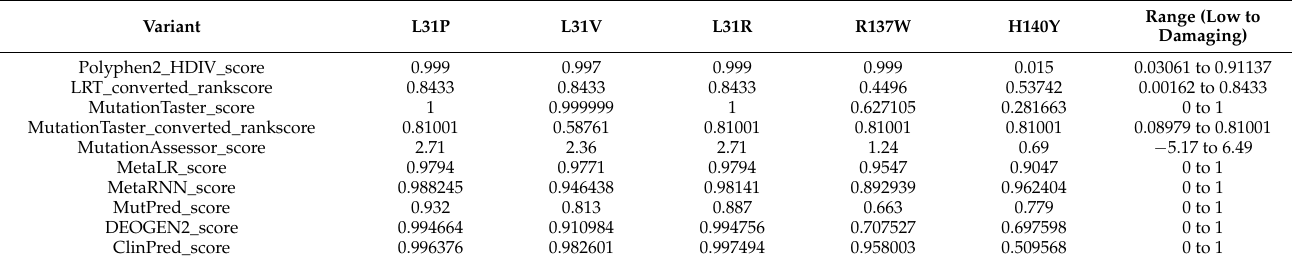
Table 2. Functional analysis of PLP variants using dbNSFP.